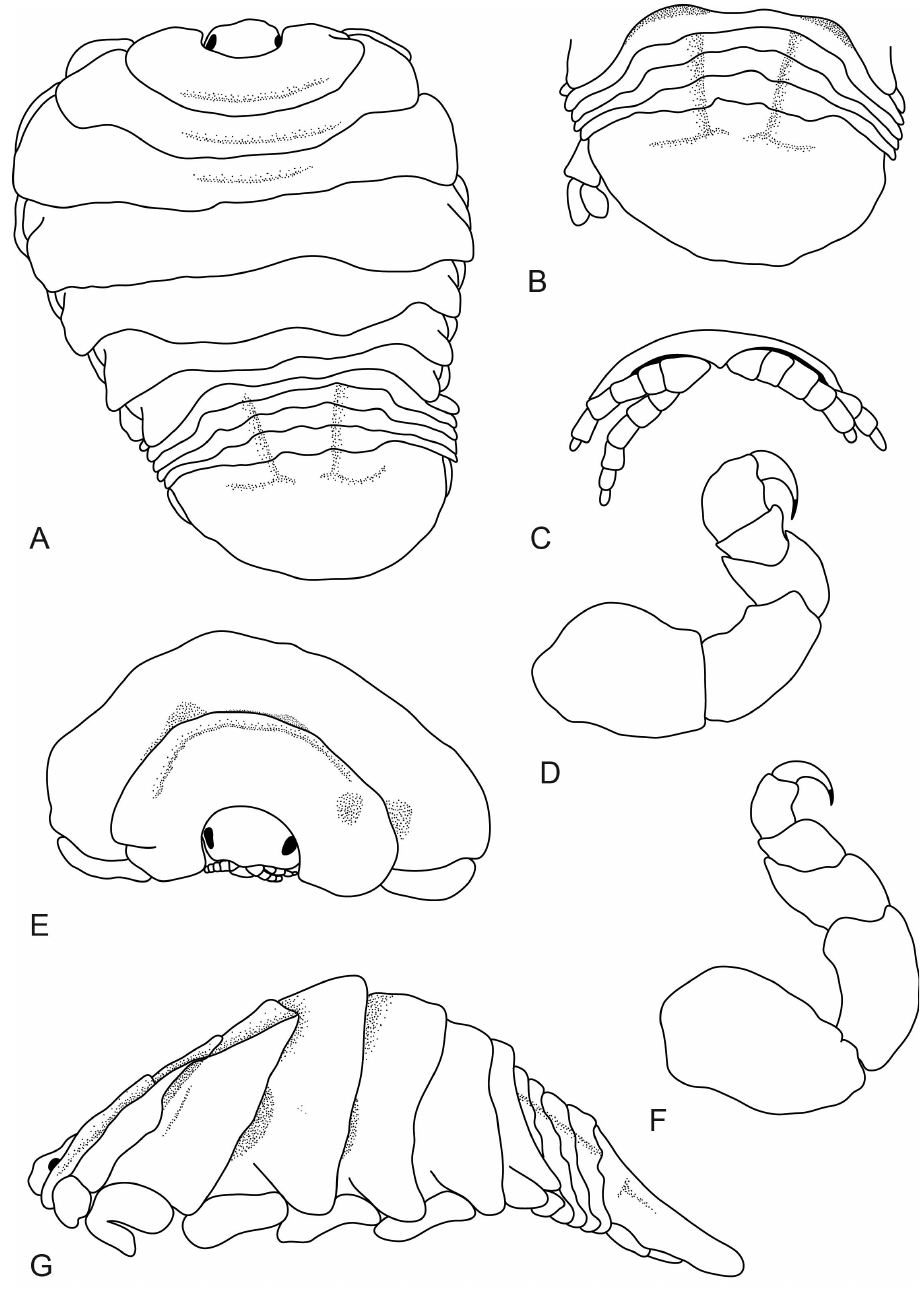
Figure 3. Elthusa winstoni sp. n., female (18 mm) (USNM 1256197). A dorsal view B dorsal view of pleotelson C ventral view of cephalon D pereopod 1 E anterior view of pereonite 1, 2 and cephalon F pereopod 7 G lateral